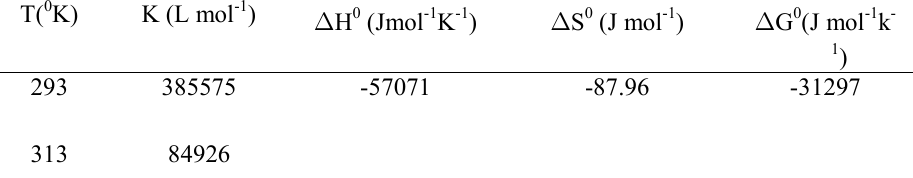
Figure 12. Effect of DNA on the viscosity of EPR solution at 100.0 μmol L -1 . C 10.0, 20.0, 30.0, 40.0 and 50.0 μmol L -1 at 298 K, phosphate buffer (0.1 mol L -1 , pH 7.4) and potassium chloride (0.1 mol L -1 ). Table 1. Thermodynamic parameters for the interaction of epirubicin with